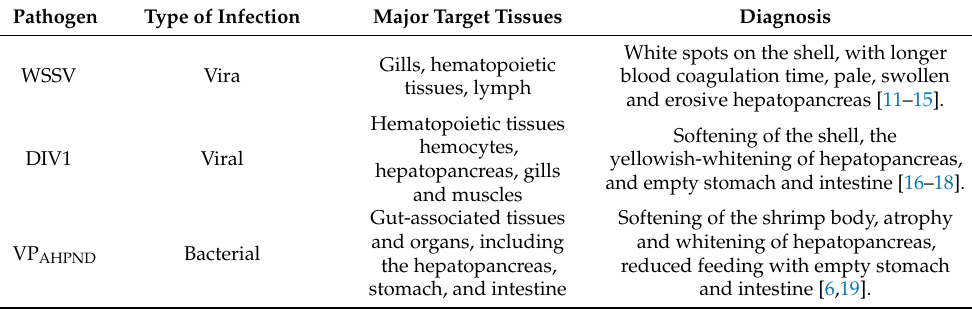
Table 1. Pathogens involved in this